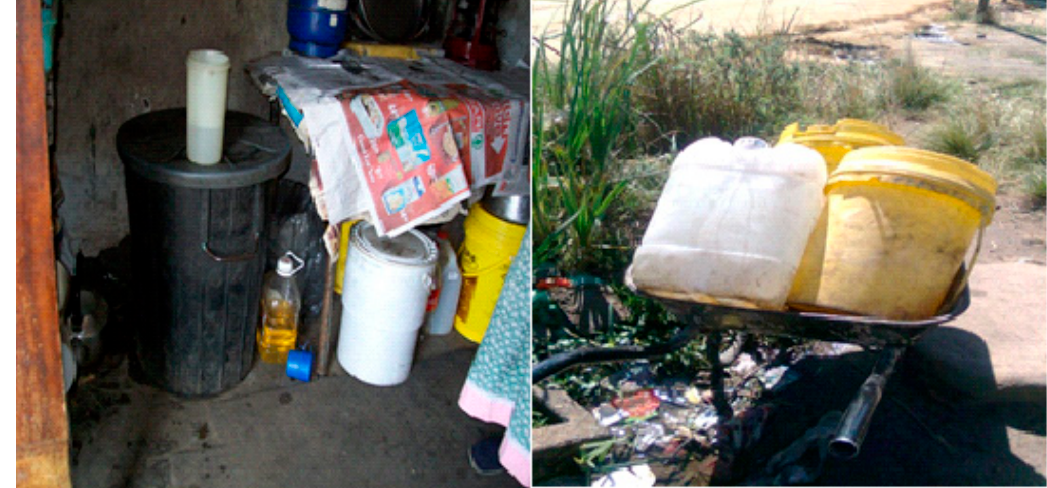
Figure 8. Containers used for the collection of drinking water from the communal standpipes and for the storage of water in the Boboyi, Bomela and Gamalakhe dwellings.